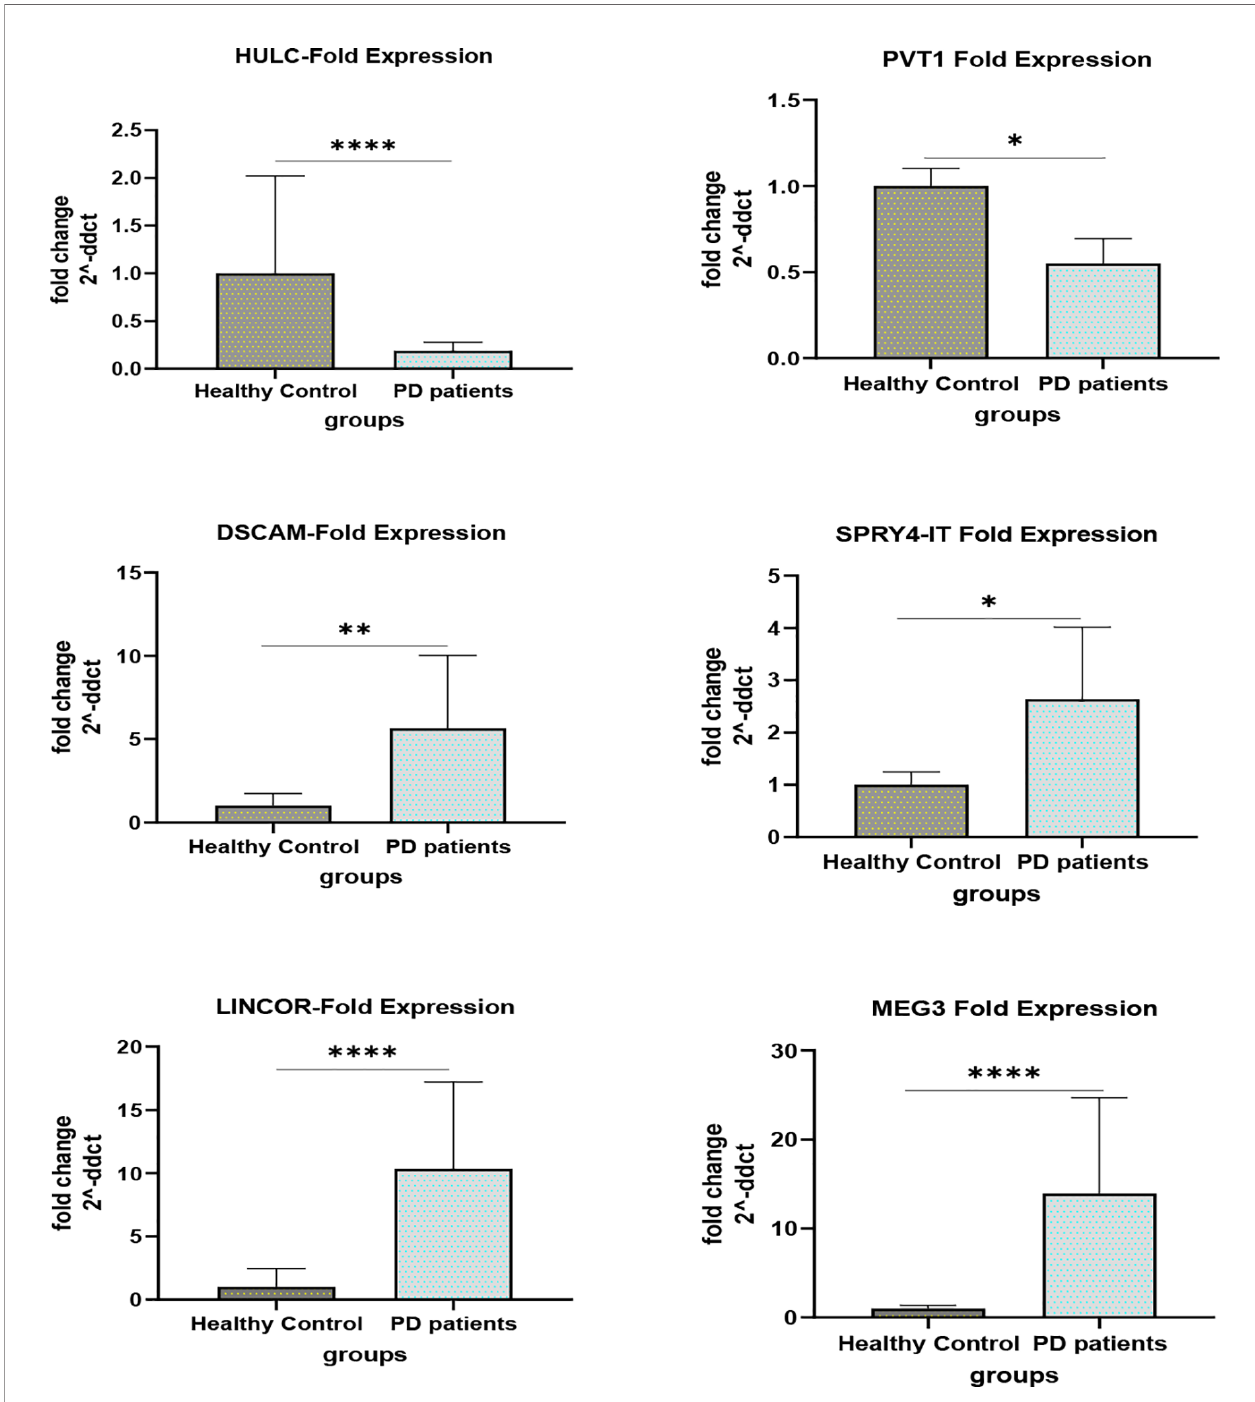
FIGURE 2 | Fold changes of lncRNAs in PD patients versus controls (*P value < 0.05, **P value < 0.001 and ****P value <